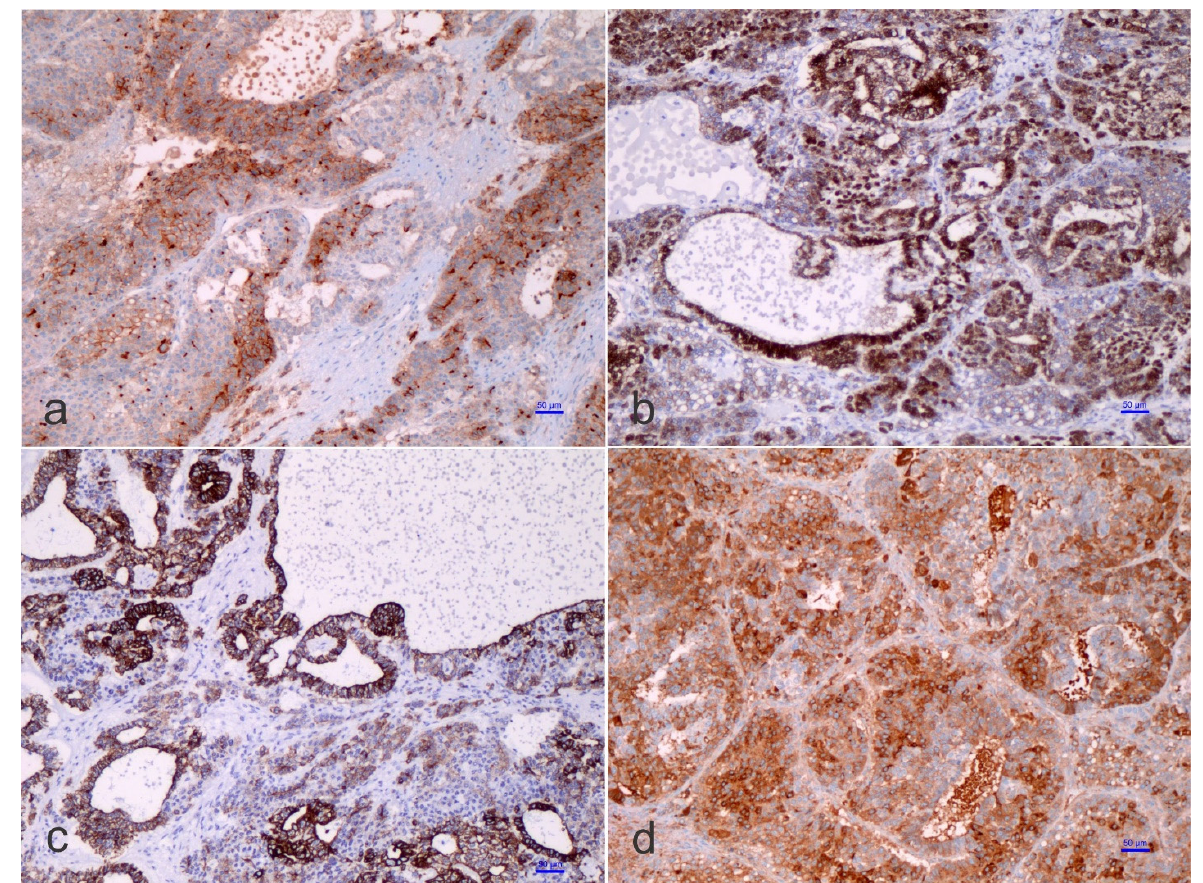
Figure 4. Immunohistochemistry of a teratoid hepatoblastoma. The microphotographs show positivity for polyclonal carcino-embryonic antigen (pCEA) (( a ), Avidin-Biotin Complex anti-pCEA immunostaining, ×100 original magnification, scale bar, 50 microns), β -catenin (( b ), Avidin-Biotin Complex anti- β -catenin immunostaining, ×100 original magnification, scale bar, 50 microns), (cyto-)keratin 19 (CK19) (( c ), Avidin-Biotin Complex anti-K19 immunostaining, ×100 original magnification, scale bar, 50 microns), and α -fetoprotein (AFP) (( d ), Avidin-Biotin Complex anti-AFP immunostaining, ×100 original magnification, scale bar, 50 microns).